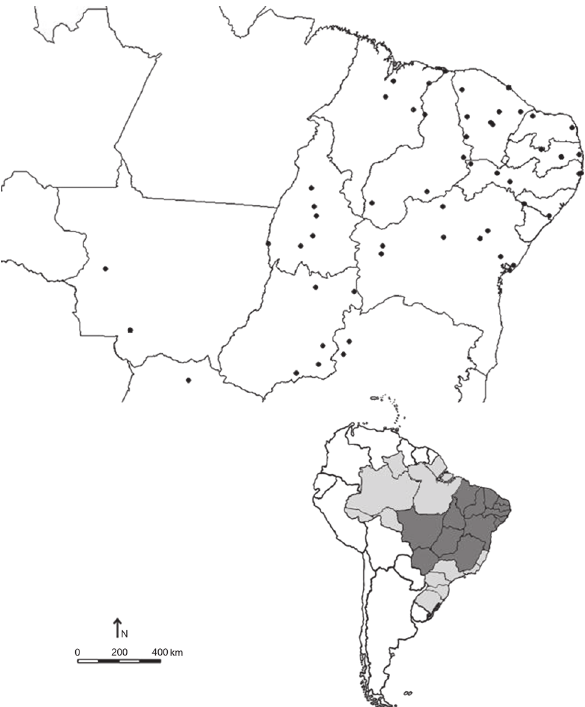
Figure 10. Known distribution of Acanthoscurria natalensis